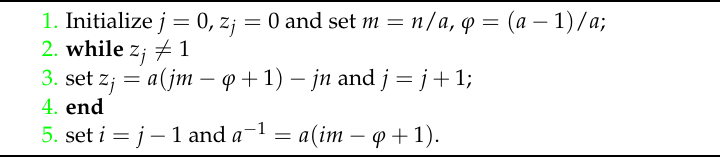
Table 4. Pseudocode of a simple algorithm to solve